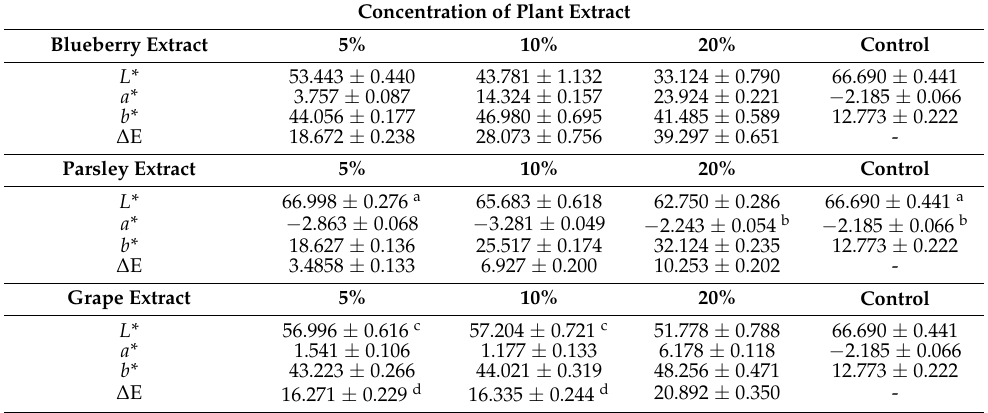
Table 6. Parameters of edible coating